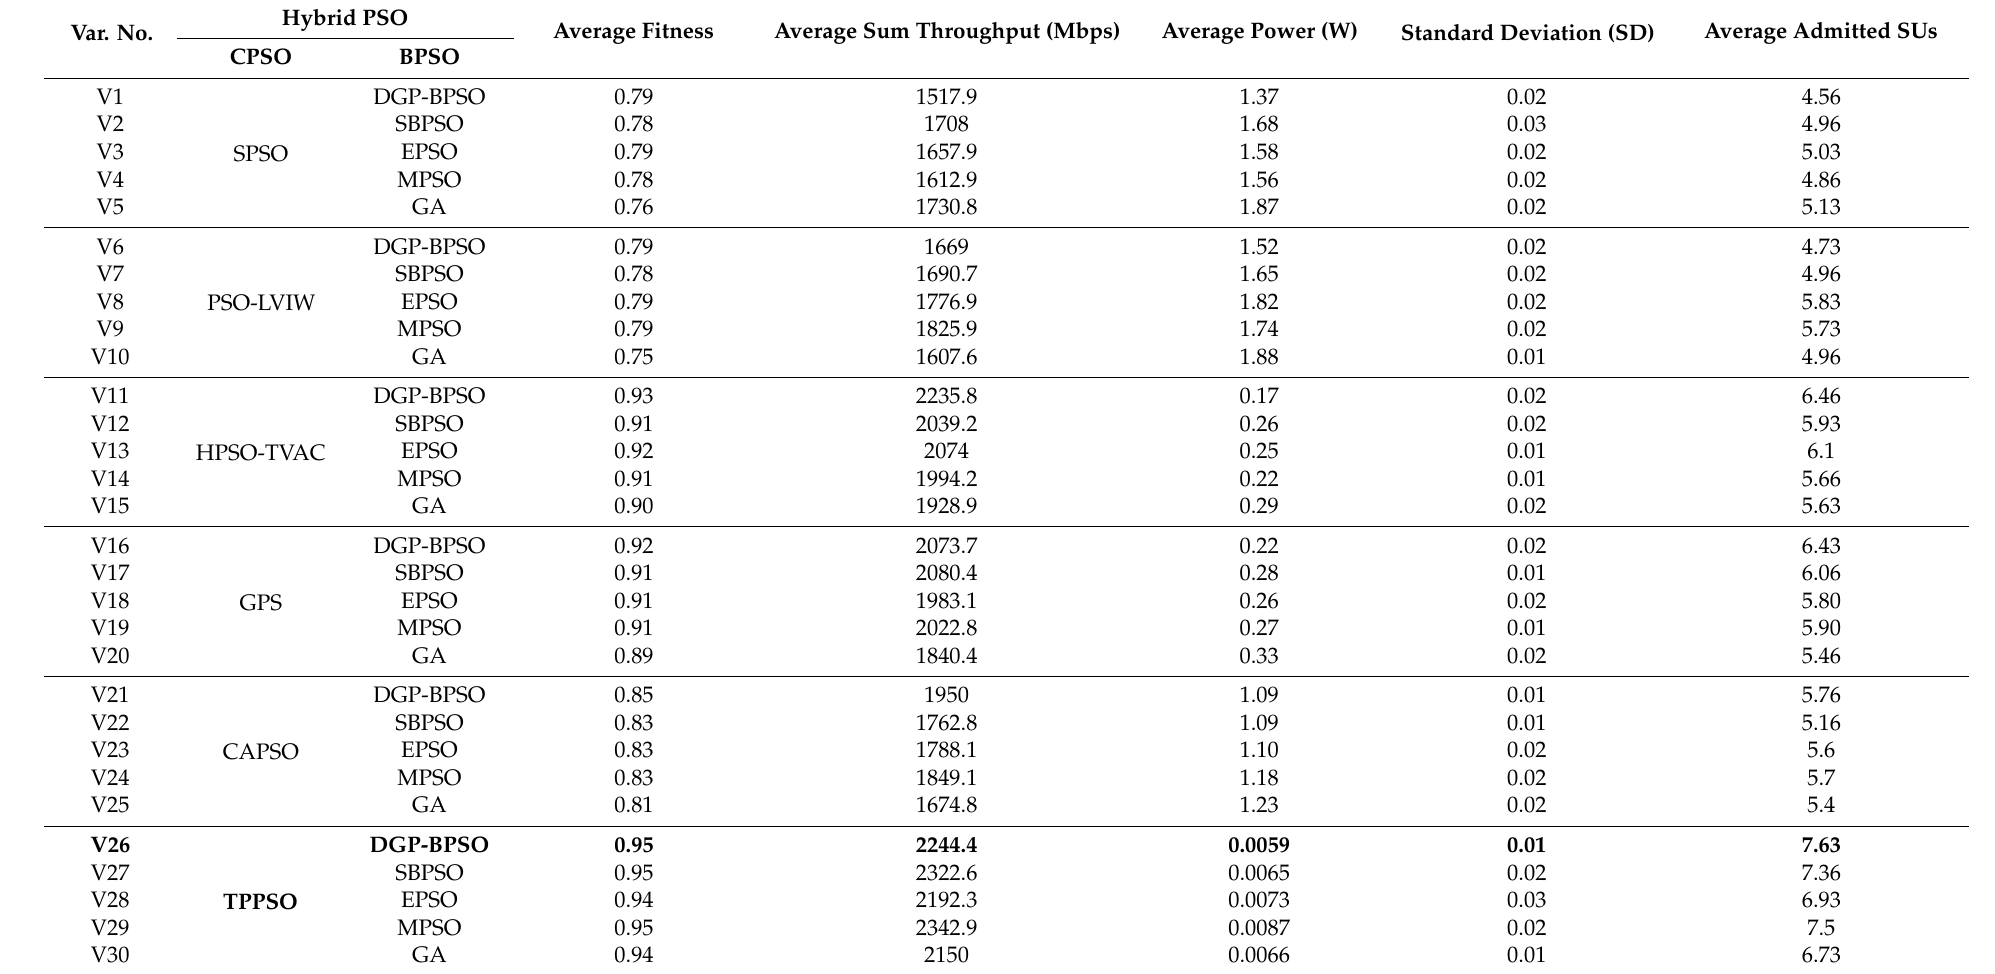
Table 8. Optimization results of the multi-objective function for power savings